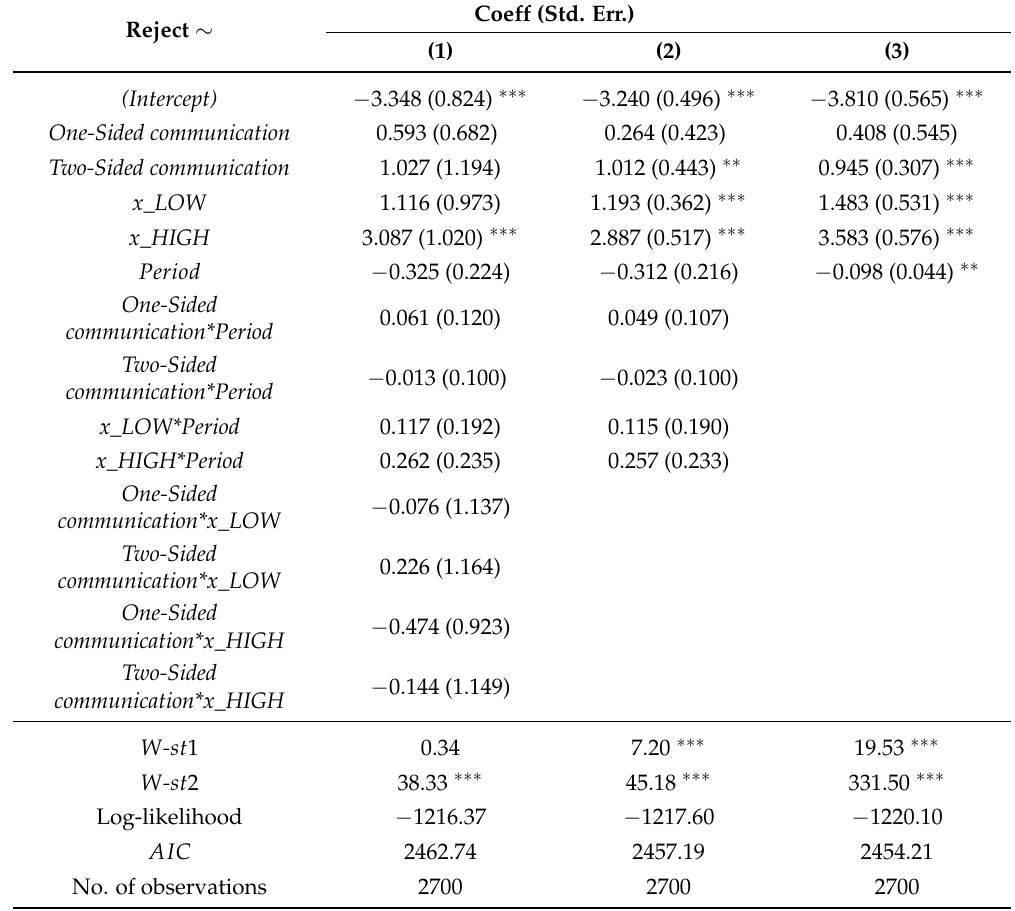
Table A4. Analysis of Responder Choices (GLLAMM: